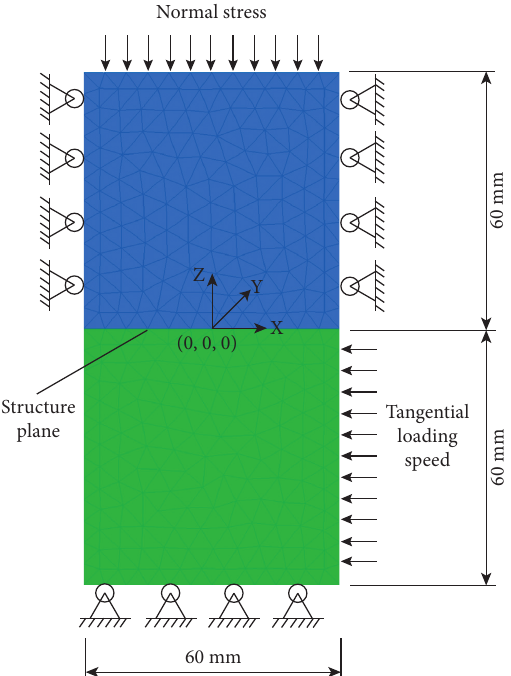
Figure 5: Constant velocity loading shear test.